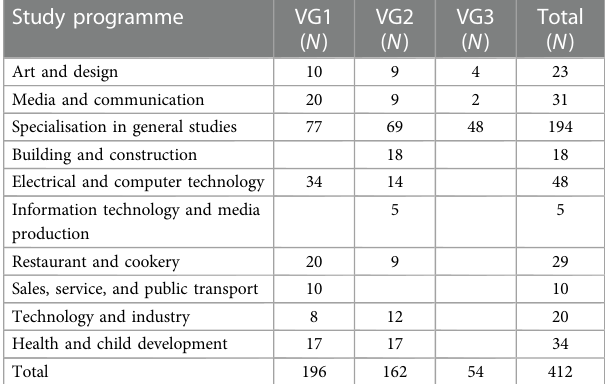
TABLE 1 Descriptive data of study programme and year group ( fi rst, second, and third year at high school). Study